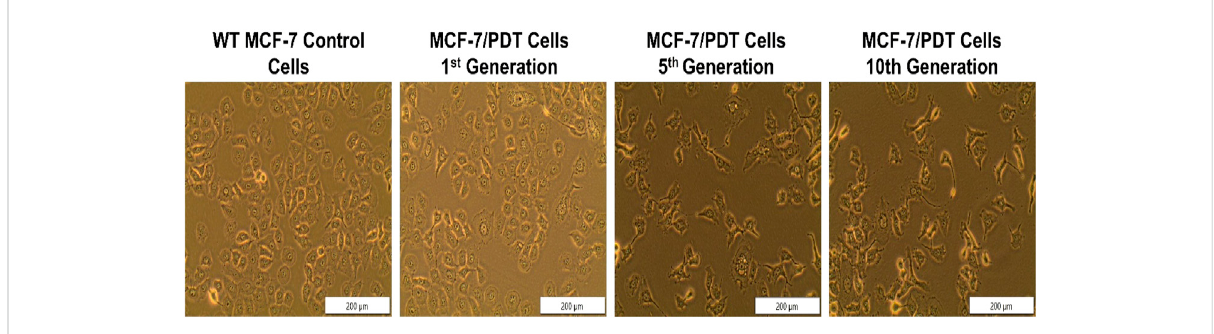
FIGURE 1 Morphological assessment of WT-MCF-7 cells and different generations of MCF-7/PDT cells. There were no observable changes except the transition from epithelial to mesenchymal cell phenotype after repeated cycles of PDT (magni fi cation 200 µm).